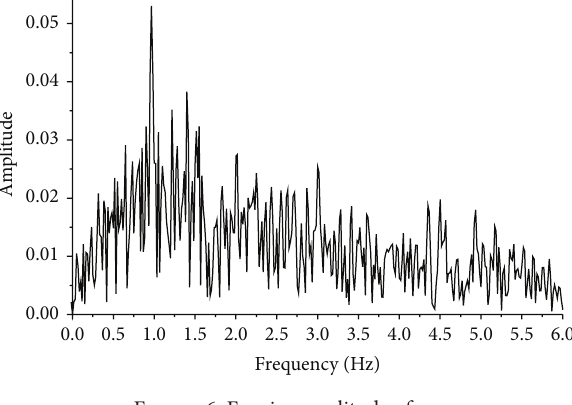
Figure 6: Fourier amplitude of 𝑐 1 .